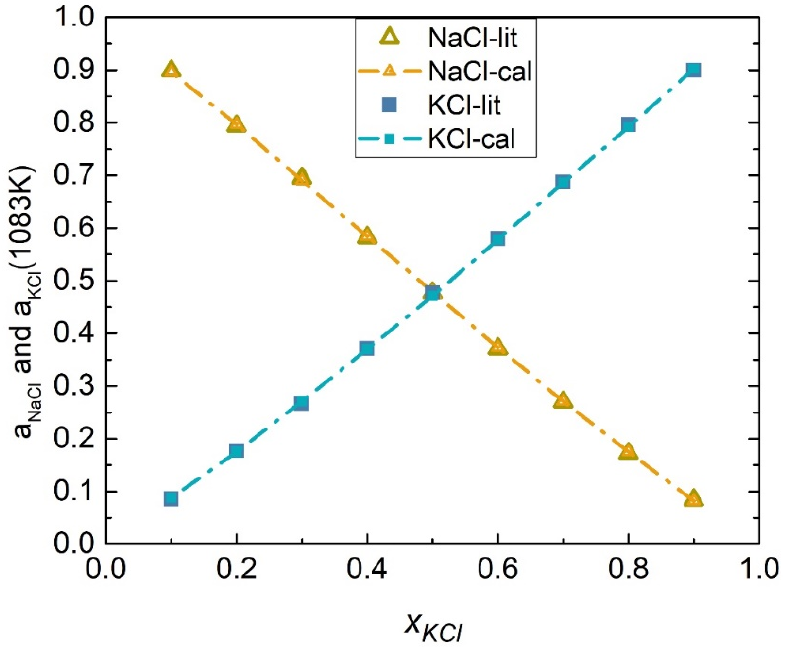
Figure 8. Comparison of the calculated activities and literature data of each element of the NaCl-KCl system (1083 K).